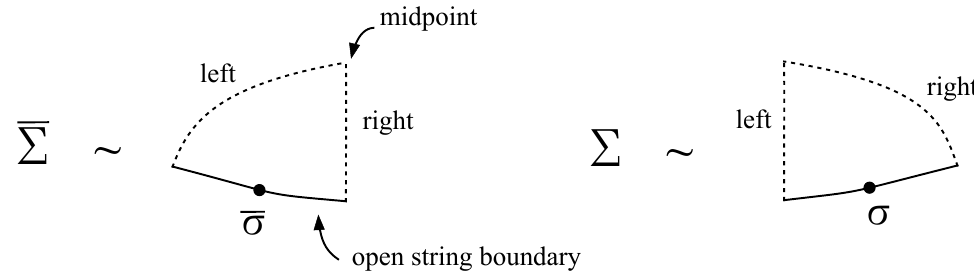
Figure 1 . Schematic representation of (cid:6) and (cid:6) as portions of the open string worldsheet bounded by curves representing the left and right halves of the string.